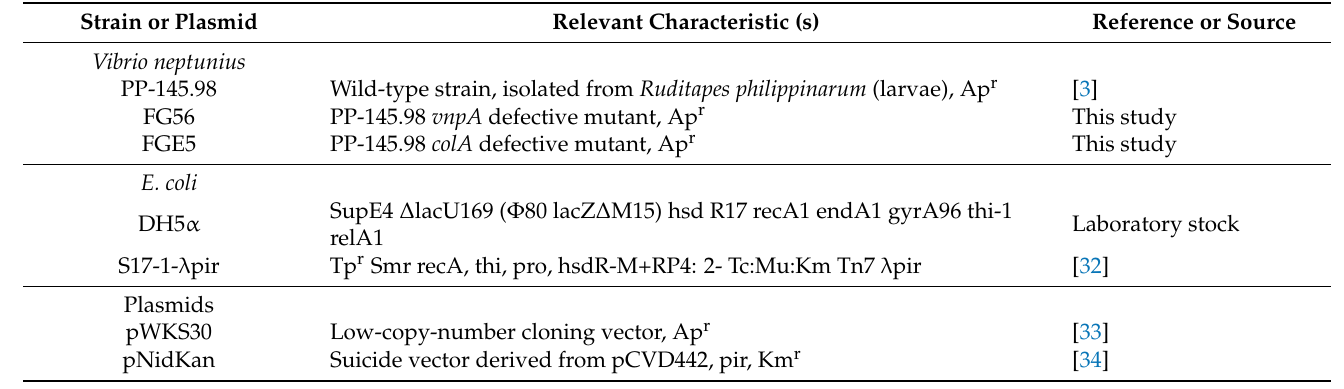
Table 1. Strains and plasmids used in this